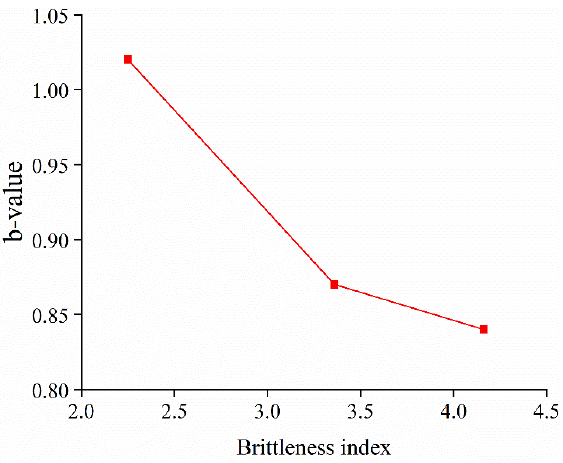
Figure 15. Relationship between the b value and the brittleness index.